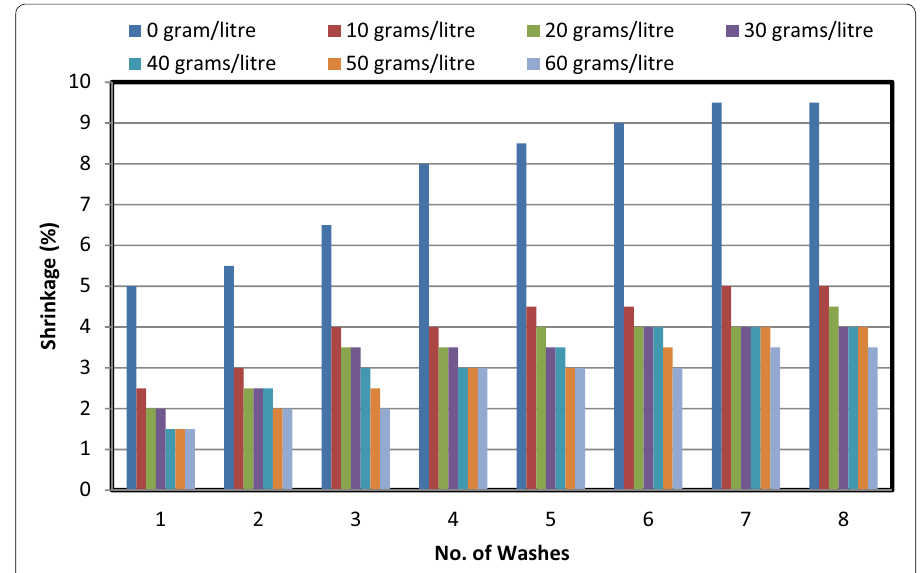
Fig. 2 Comparison of warp wise shrinkage of untreated (0 g/L) and treated cotton with fluorocarbon at 10 to 60 g/L. Warp-wise shrinkage of untreated and treated cotton